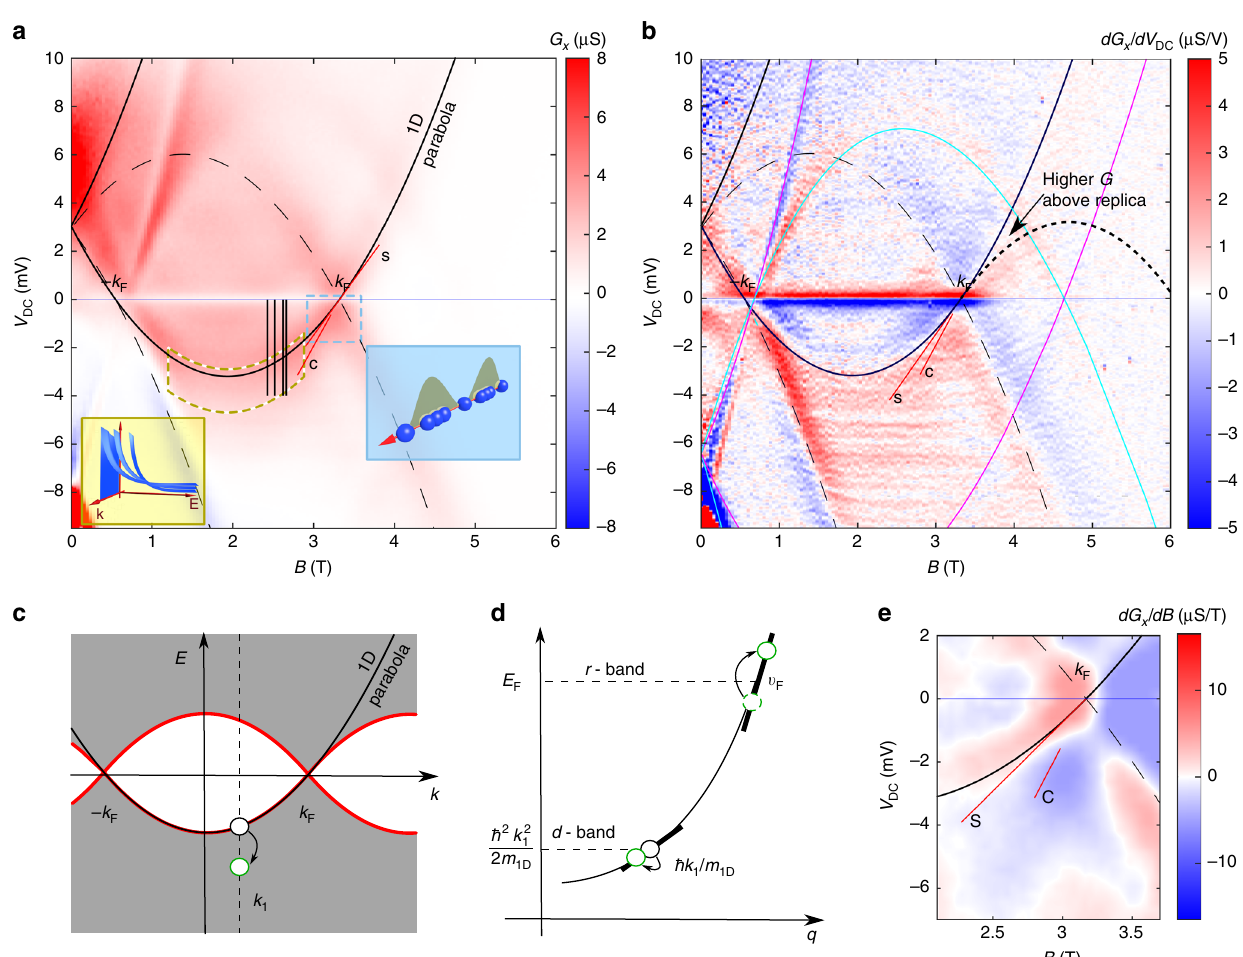
Fig. 2 Conductance maps of spectra, and types of excitation. a Overview of conductance G ¼ d I = d V vs B ( ∝ momentum) and voltage V DC ( ∝ energy eV DC ) (Sample A). The region along which G is enhanced is shown enclosed by a dashed yellow line, and the left inset shows how G might decay with energy, differently for each momentum k . Vertical black lines show cuts along which fi tting is carried out. The region where spin – charge separation is visible is shown enclosed by a dashed blue line; the right inset illustrates charge (dots) and spin (shaded) waves. The bottom edge of the yellow region is selected as the line above which the nLL model still gives a reasonable fi t, see Fig. 4. b Differential d G = d V of the raw data in ( a ), showing a replica above k F (where D C the conductance stays higher than expected for the non-interacting model in the region labelled Higher G , and then appears to drop off along a parabola that is an inverted replica of the main 1D parabola), separate spin and charge lines near V DC = 0, labelled S and C, respectively and the parasitic signal (near magenta and cyan lines). c Dispersion of an interacting 1D system. The kinematically forbidden region is shown in white (see explanation in text), and grey indicates the continuum of many-body excitations. The thick red line is the border between the two regions. States on the border correspond to removing a single particle (black circle at k 1 ) from the many-particle state, and a higher-energy excitation described by the mobile-impurity model is marked by a green circle. d Splitting of fermionic dispersion into two subbands, one for a heavy hole with velocity (cid:1) hk 1 = m and one for excitations around E F 1D with velocity v F . Green circles are constituent parts of many-body excitations in the nonlinear regime (see explanation in text). e d G /d B around the spin (S) ¼ 1 : 32 ´ 10 5 ms (cid:2) 1 and charge velocity of v ¼ 1 : 73 ´ 10 5 ms (cid:2) 1 , respectively, with error and charge (C) lines. Their slopes indicate a spin-wave velocity of v s c bars of ~10%, see Supplementary Table